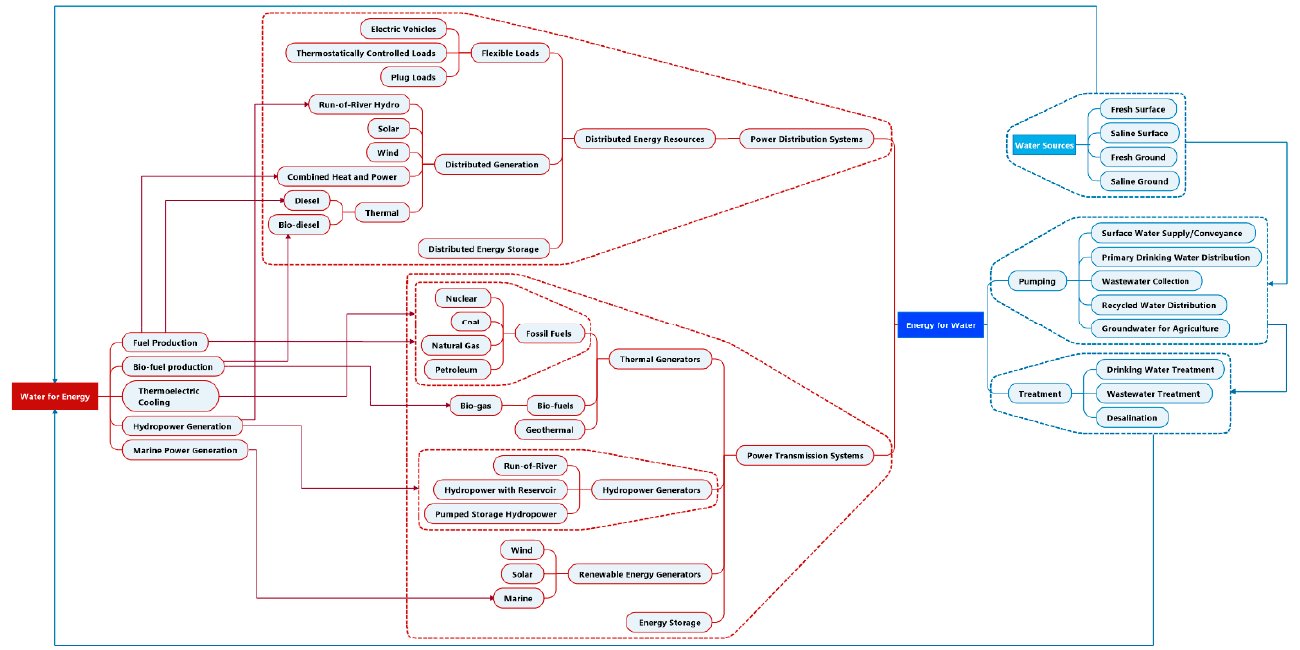
Figure 3. Visualization of WPS interdependencies.